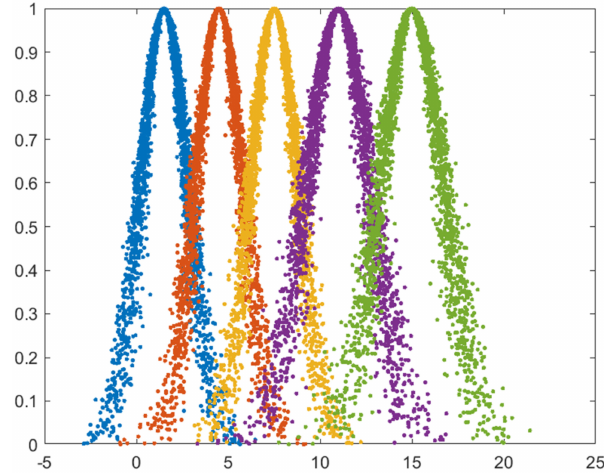
Figure 5. Per capita fiscal revenue cloud model.